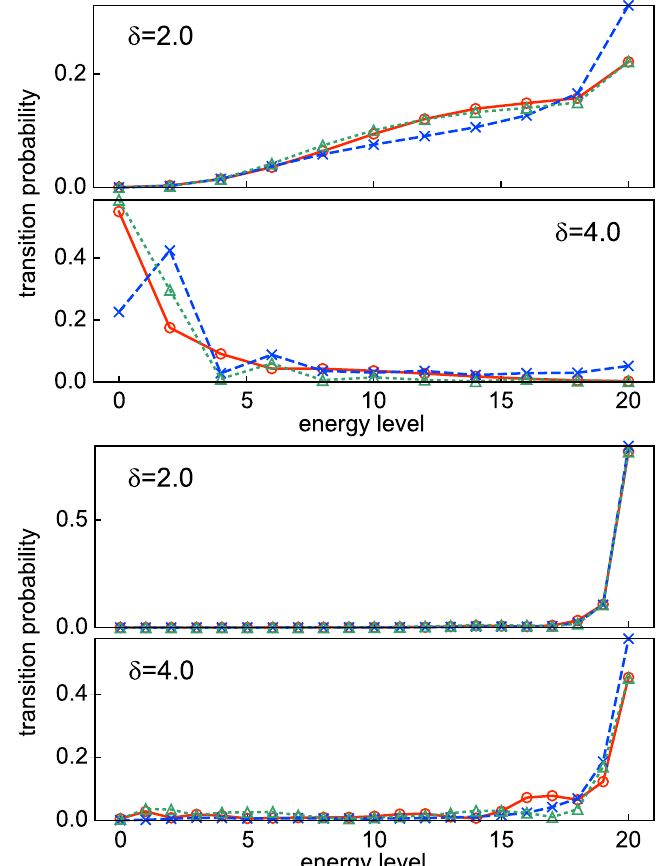
Figure 7: (Top) Transition-probability distributions for ˆ H energy level takes even value: 0,2,4,...,20. (Bottom) Distributions for ˆ H N = 20. The energy level takes integer value: 0,1,2,...,20. Legend is the same as in Fig.